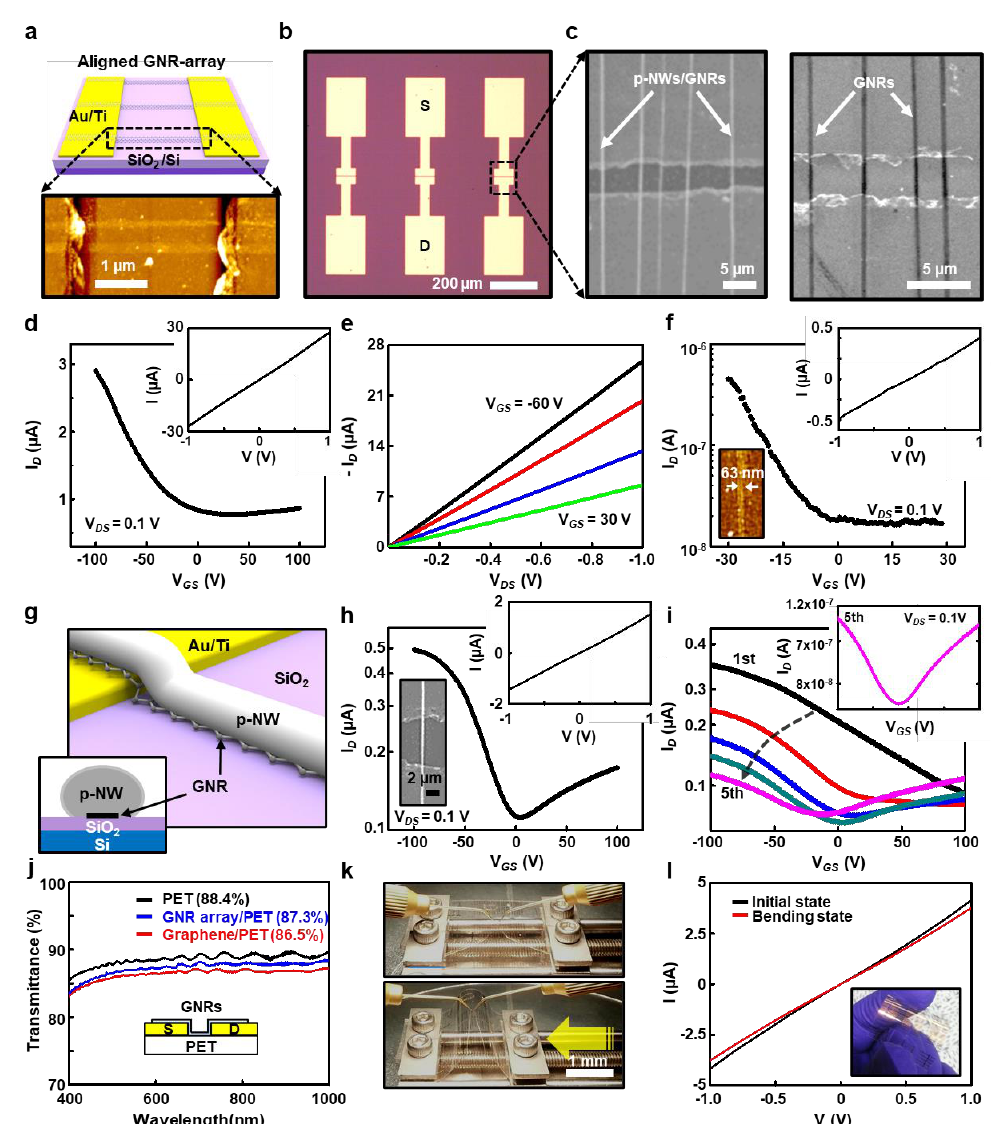
Figure 4. ( a ) Schematic of the bottom-gated GNR-FET (top) and the AFM images of the GNR array in between the electric pads (bottom). ( b ) Optical micrograph of the GNR-FET arrays. ( c ) The magnified SEM images of the p-NW etch-mask and GNRs in the active channel; all devices have ~4.7 μm channel lengths. ( d , e ) Drain current ( I D ) as a function of gate voltage ( V G ) for a multichannel GNRs (~20) in the source/drain bias ( V DS ) of 0.1 V, and the corresponding output characteristic of GNR-FET. ( f ) Representative transfer curve on a transistor that incorporates a single-channel of a GNR; the width was measured by AFM as ~63 nm (inset). ( g ) Schematic of the single-channel GNR, encapsulated by a p-NW (inset: cross-sectional view of GNRs in its longitudinal direction). ( h ) Typical transfer curve with charge neutral point centered at the charge-neutral point (inset: a representative SEM image of the single-channel GNR). ( i ) Ambipolar behavior of GNR-FET incorporated with the electric field annealing process. ( j ) The transmittance of the GNR-based two-terminal device on a PET substrate (inset shows a side view of the device). ( k ) Photographs for the demonstration of a flexible device placed in the bending stage. ( l ) Current density–voltage ( I – V ) characteristics for a representative device; linear fits define the effective resistance (inset: a photograph of the flexible device).